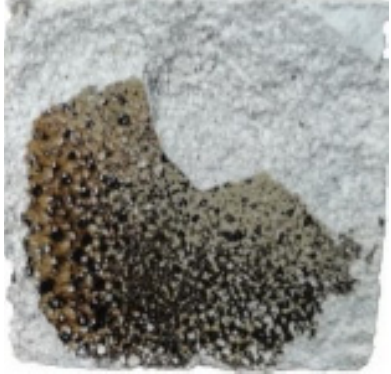
Figure 8. Fracture surface of the specimen.